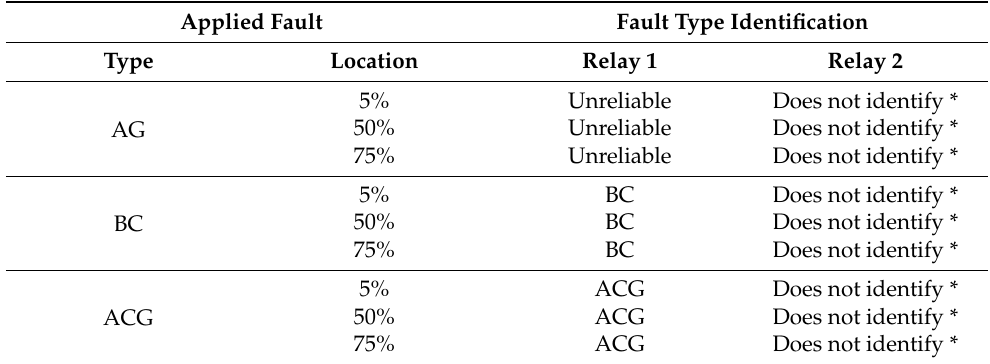
Table 1. Fault type identification of relays for low impedance